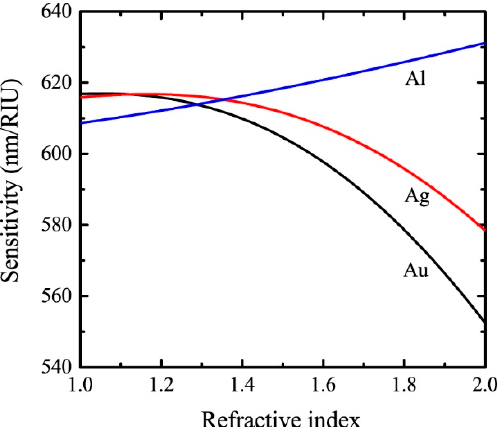
Figure 4. The refractive index dependence of the sensitivity for SPR sensors with a period of 600 nm and a resonant wavelength of 800 nm.